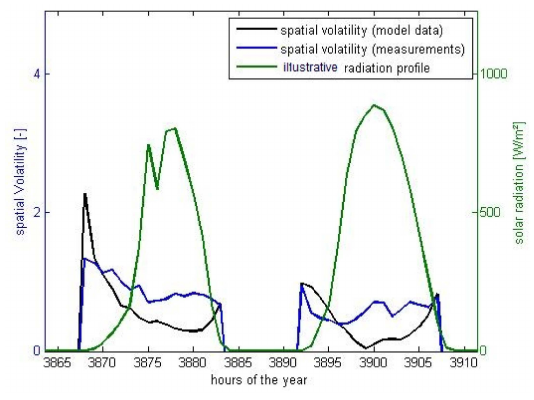
Figure 8. Spatial volatility of the measured and modeled data on two illustrative days.